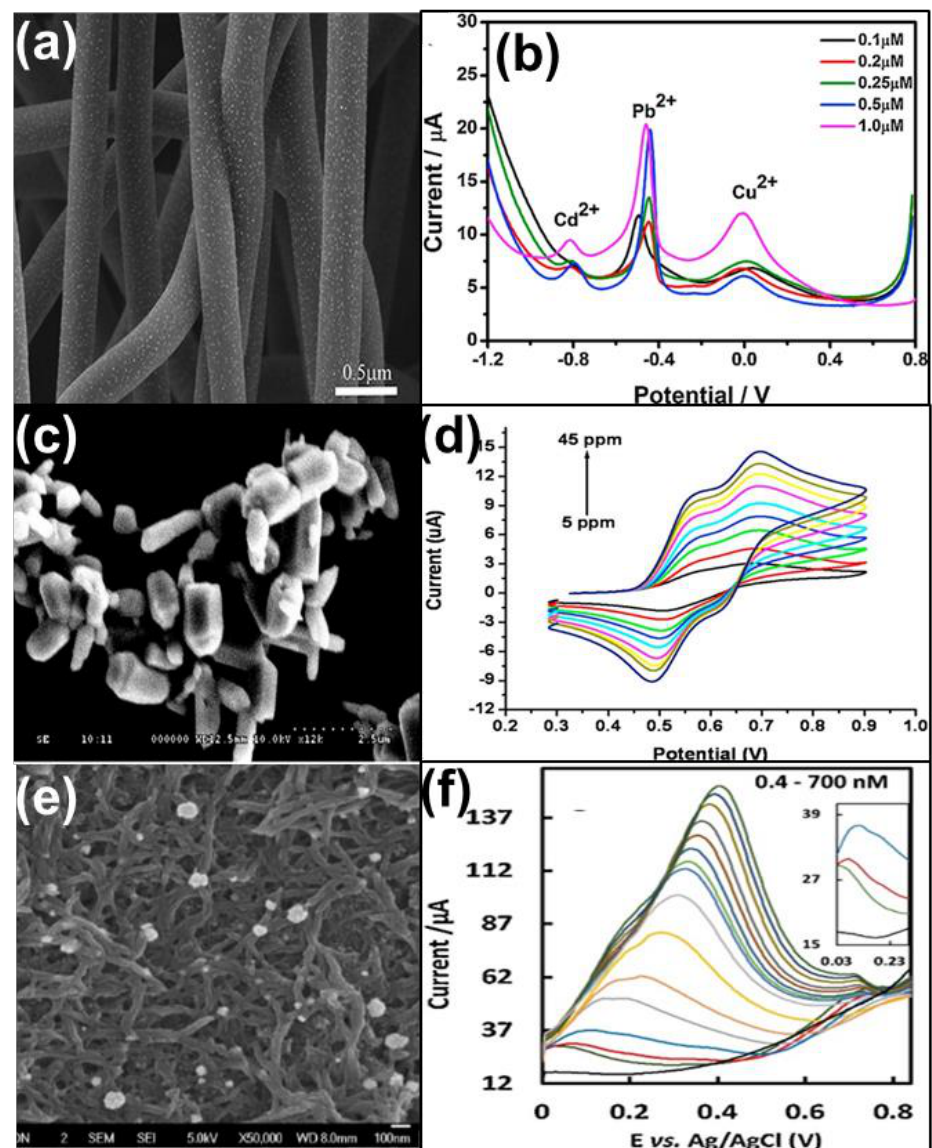
Figure 2. ( a ) FESEM image and ( b ) SWASV of AuNPs/CNFs for simultaneous detection of Cd, Pb, and Cu ions [32]; ( c ) FESEM image of ZnO nanopillar; ( d ) CV of ZnO/Nafion/Au sensor for detection of Cd ions with Ag/AgCl as the reference electrode [32]; ( e ) FESEM image of Au/PANOA; and ( f ) SWASV of Au/PANOA/SPCE for the detection of Hg ions [34].